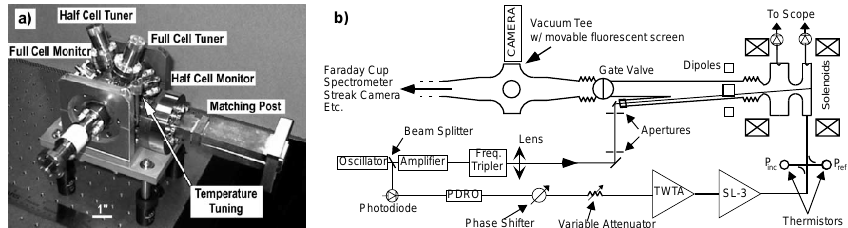
FIG. 1. (a) Photograph of the X -band rf gun, showing the tuning and monitoring features, and (b) a schematic of the experimental setup.